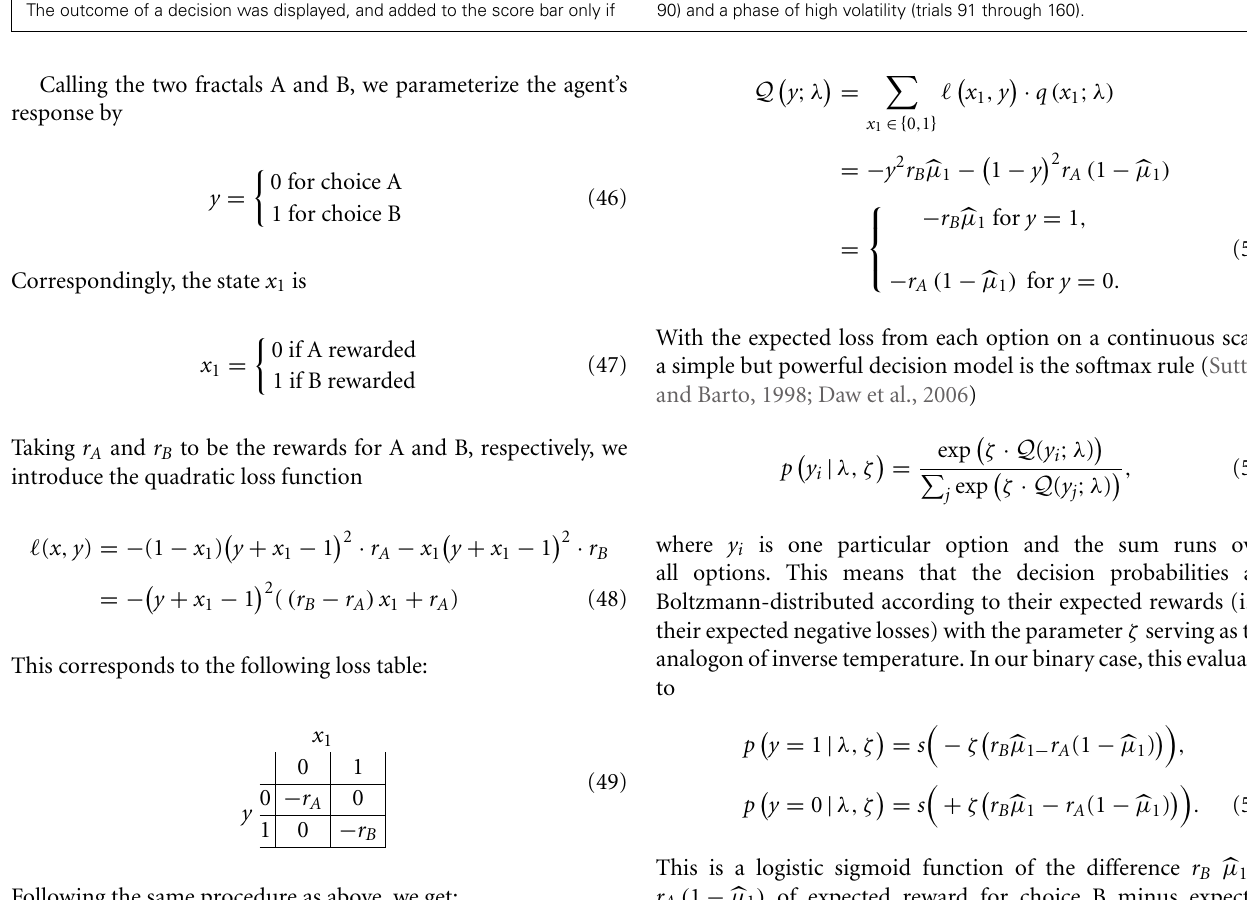
the chosen card was rewarded. (iv) Inter-trial interval (ITI). The screen only showed the score bar, until the beginning of the next trial. Our experimental paradigm consisted of a number of phases with different reward structures. Different phase lengths induced both a phase of low volatility (trials 1 through 90) and a phase of high volatility (trials 91 through